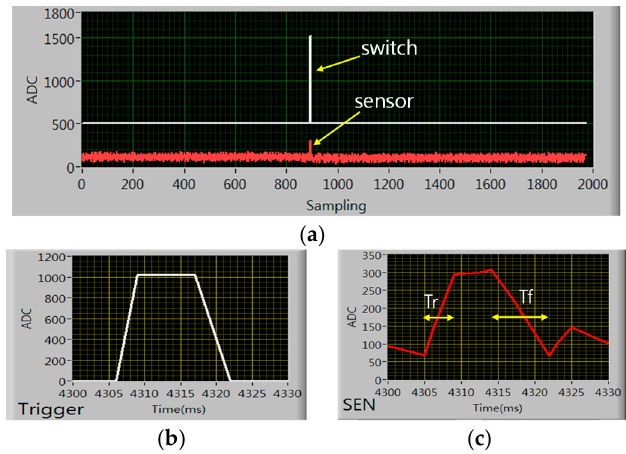
Figure 8. Time response with hammering: ( a ) switch and sensor outputs due to hammering ( b ) switch output, ( c ) sample output waveform.